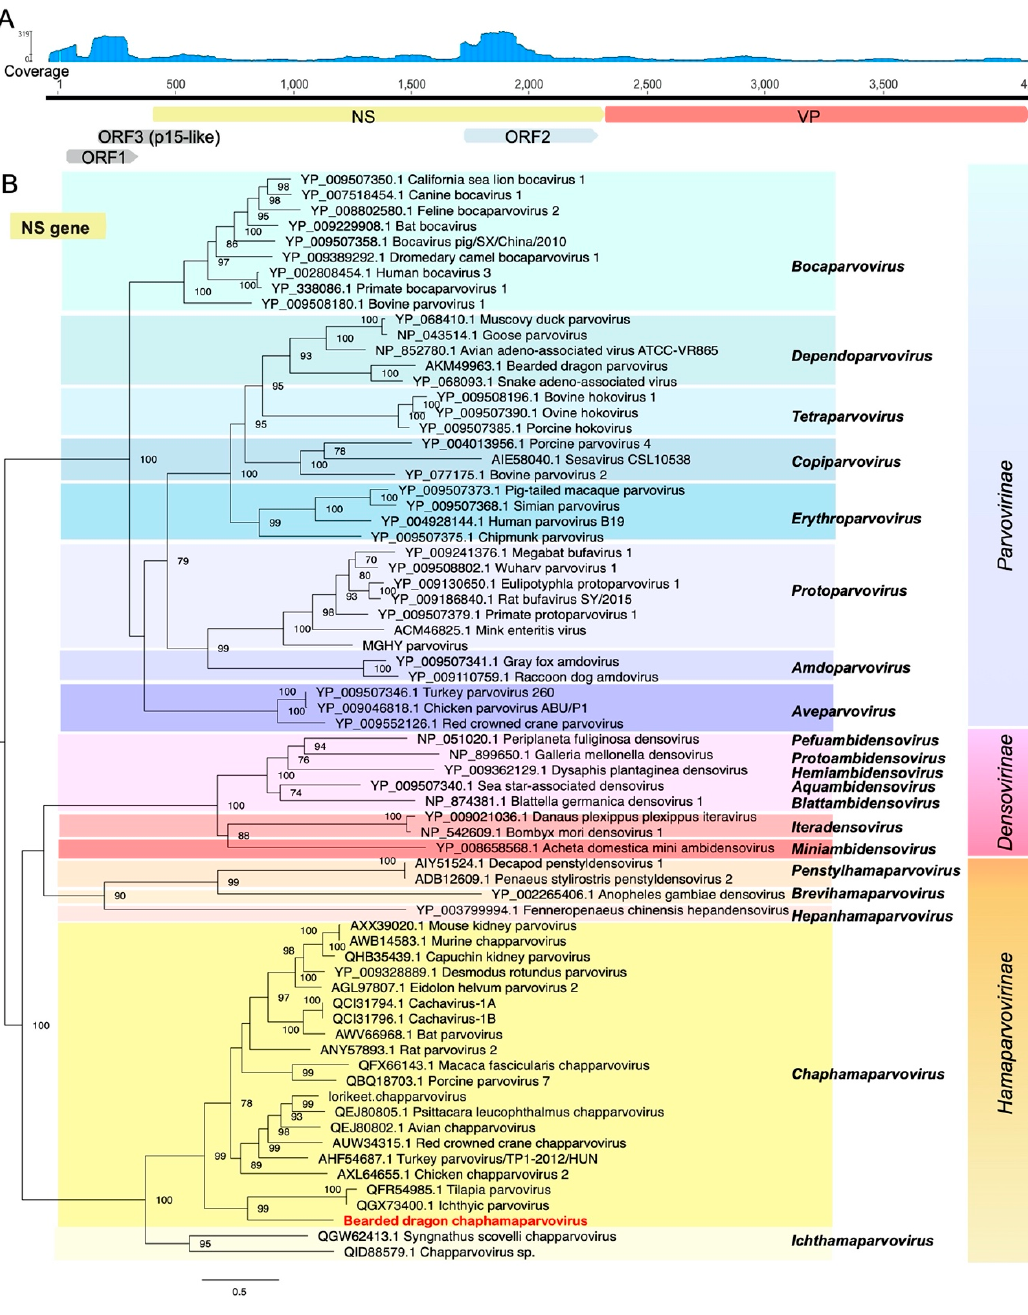
Figure 4. Genome characterization and phylogenetic relationships of bearded dragon Figure4. Genomecharacterizationandphylogeneticrelationshipsofbeardeddragonchaphamaparvovirus. chaphamaparvovirus. ( A ) Genome depiction and reads mapping coverage of bearded dragon ( A ) Genome depiction and reads mapping coverage of bearded dragon chaphamaparvovirus. chaphamaparvovirus. ( B ) Phylogenetic analysis of the nonstructural protein gene (NS gene) of ( B ) Phylogenetic analysis of the nonstructural protein gene (NS gene) of parvoviruses, including parvoviruses, including other chaphamaparvoviruses and members of the Parvovirinae , Densovirinae, other chaphamaparvoviruses and members of the Parvovirinae , Densovirinae, and Hamaparvovirine . and Hamaparvovirine . Bootstrap values >70% were presented for key nodes (1000 replicates). The tree Bootstrap values > 70% were presented for key nodes (1000 replicates). The tree was midpoint rooted for was midpoint rooted for clarity only. Scale bar shows the number of substitutions per site. clarity only. Scale bar shows the number of substitutions per